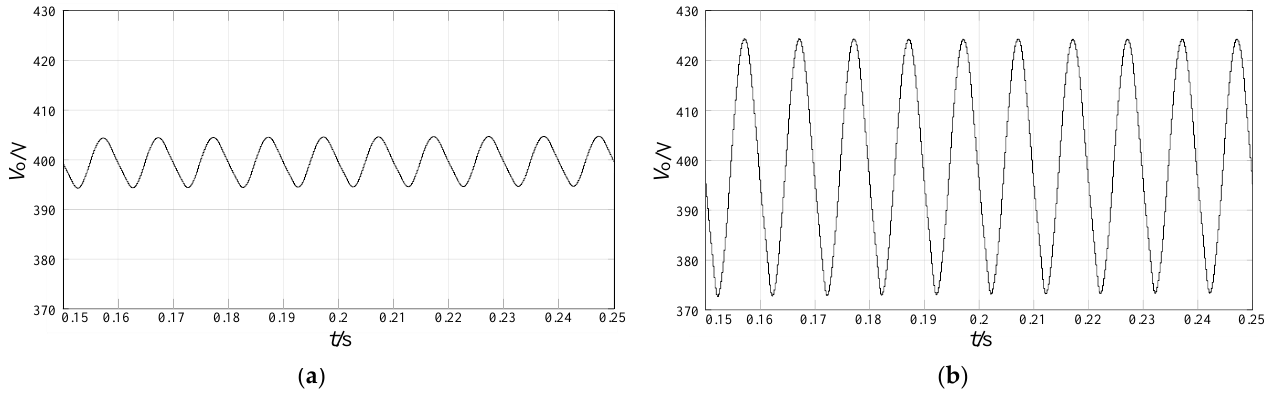
Figure 11. Output voltage ripple of bridgeless PFC converter under different capacitance values: ( a ) output filter capacitance C o = 220 μF ; ( b ) output filter capacitance C o = 40 μF .